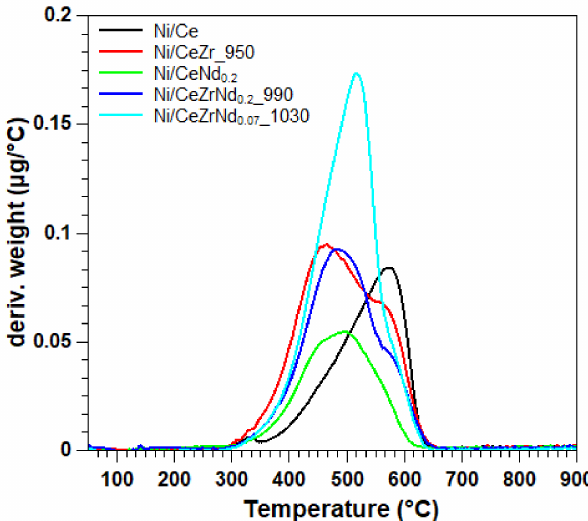
Figure 9. Thermogravimetric results of exhausted catalysts after 8 h of testing at 650 ◦